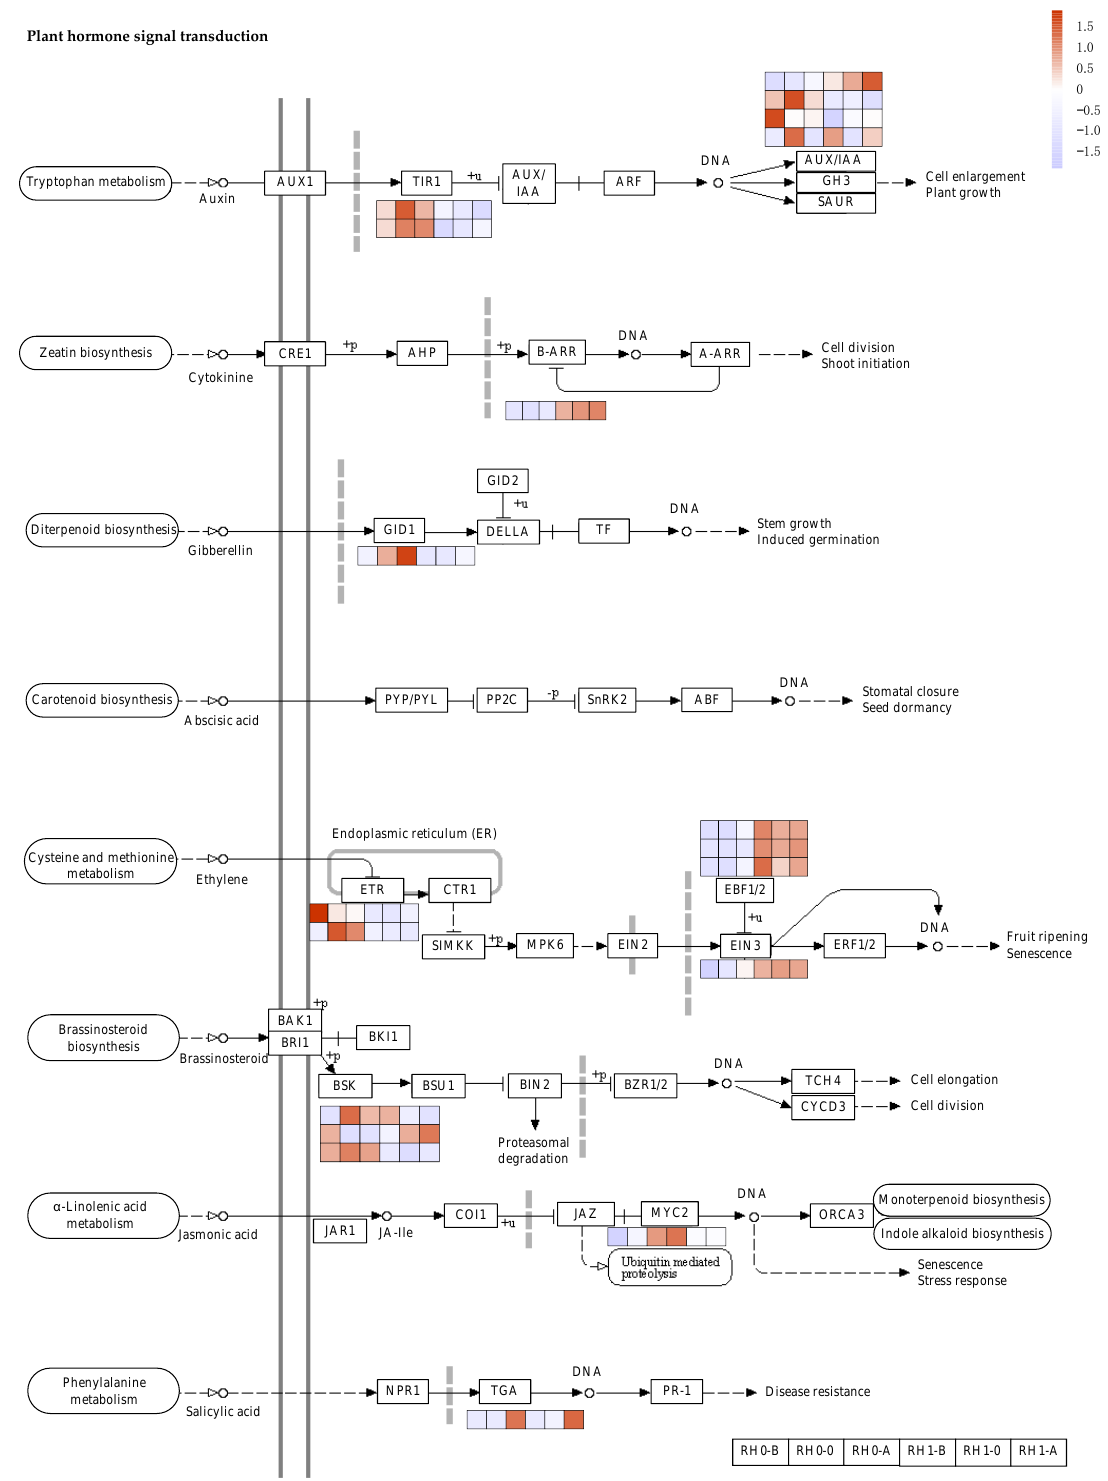
Figure 5. Expression pattern of key DEGs in hormone signal transduction at different development stage of two-type roots in A. beshanzuensis .